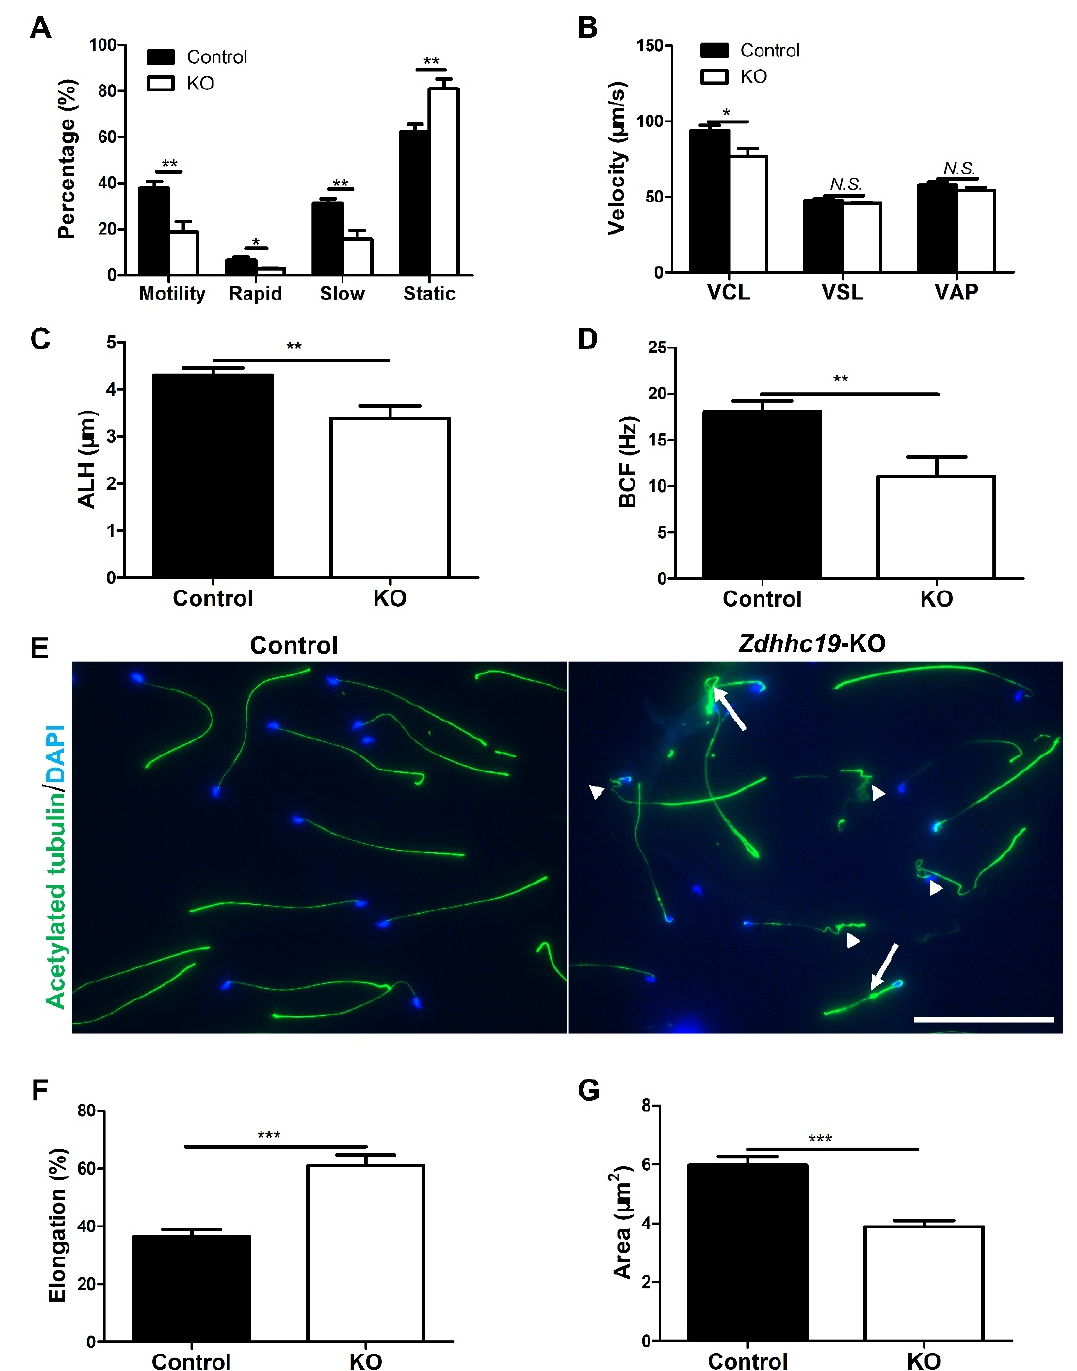
Figure 4. Zdhhc19 deletion caused abnormal sperm motility and sperm flagella. ( A ) CASA analyses of sperm motility on Zdhhc19 KO and control littermates. ( B ) Analyses of sperm velocity by CASA. VCL, curvilinear velocity; VSL, straight line velocity; VAP, average path velocity. ( C ) Analyses of sperm amplitude of lateral head displacement (ALH) by CASA. ( D ) Analyses of sperm beat/cross frequency (BCF) by CASA. ( E ) Immunofluorescence analyses of acetylated-TUBULIN on spermatozoa from adult KO and control littermates, counter-stained with DAPI. White arrows indicate sperm with bent tails, while arrowheads point to coiled sperm tails. Scale bars, 200 µ m. ( F , G ) Analyses of sperm elongation ( F ) and sperm area ( G ) by CASA. ( A – D , F , G ) Data are represented as the mean ± SEM of three sperm samples per group. * p < 0.05; ** p < 0.01, *** p < 0.001; N.S.: no significance.